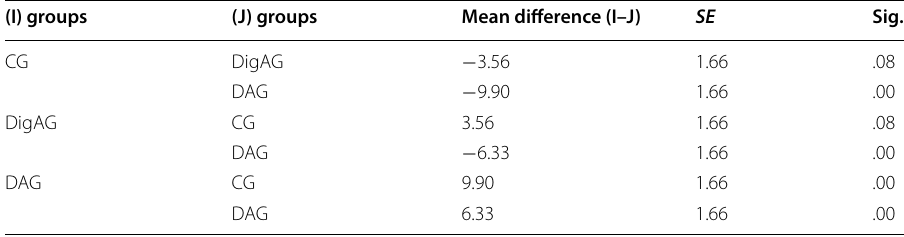
Table 15 Comparing cognitive load posttest of all groups by using a Scheffe test (I) groups (J) groups Mean difference (I–J) SE Sig. CG DigAG